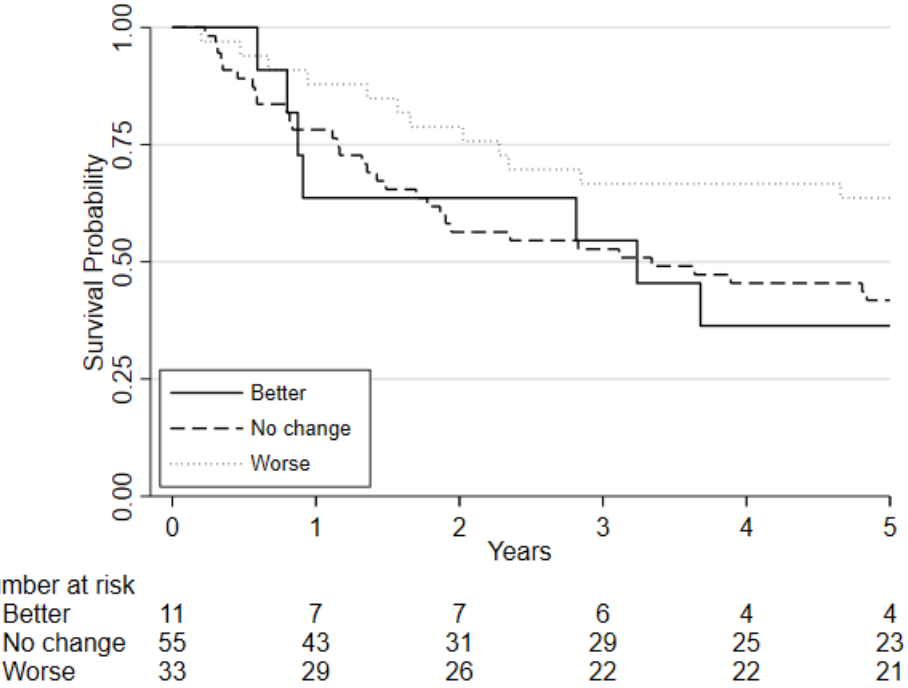
Figure 3. Kaplan-Meier plot of the estimated overall 5-year survival among patients with oesophago-gastric cancer who underwent CPET pre-and post-NAC/CRT followed by surgery, based on their change in VO following chemo/chemoradiotherapy